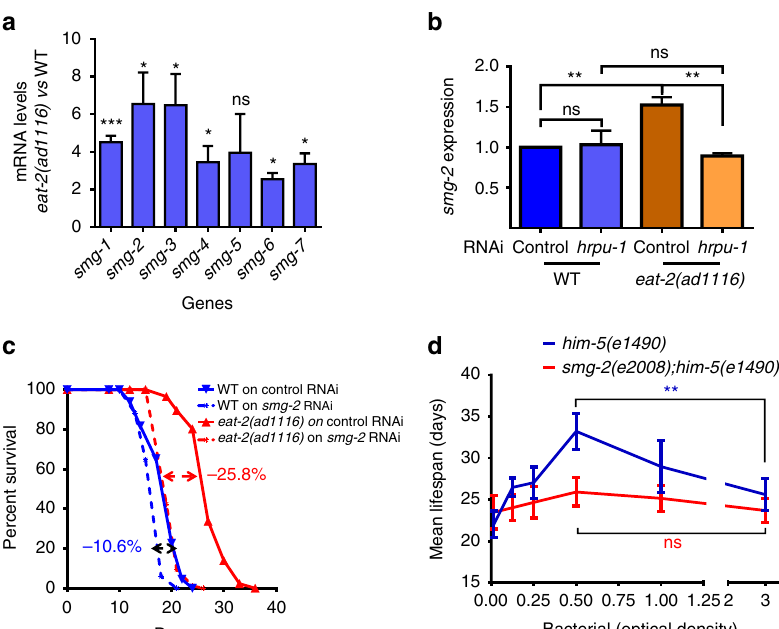
Fig. 4 MRNA surveillance pathway is upregulated and required for DR-mediated longevity. a qRT-PCR showing that genes of NMD pathway are upregulated in eat-2(ad1116) at day 1 of adulthood. Expression levels were normalized to actin and compared to WT worms. Averages of three biological replicates are shown ( Error bars = SEM). Asterisks indicate statistically signi fi cant differences to the corresponding WT samples, as calculated by unpaired two-tailed t- test (* P ≤ 0.05; ** P ≤ 0.01, *** P ≤ 0.001, ns non-signi fi cant). b The expression of smg-2 is upregulated in eat-2(ad1116) compared to WT, in a hrpu-1 -dependent manner. The samples were collected on day 3 of adulthood. Data shown are average of three biological replicates. ( Error bars = SEM). Statistical analysis was performed using unpaired two-tailed t- test. ** P ≤ 0.01, ns non-signi fi cant. c Lifespan of WT and eat-2(ad1116 ) grown on control or smg-2 RNAi. One out of the three biological replicates are shown. Percentage of suppression of lifespan is indicated for each strain. Lifespan data for each individual experiment are provided in Supplementary Table 4. d Bell-shaped curve generated by plotting average lifespans of him-5(e1490) grown in the presence of different dilutions of bacteria. The smg-2(e2008);him-5(e1490) mutant worms failed to produce similar curve. An average of three independent biological replicates is shown. Error bars are SEM. Two-way ANOVA revealed that the lifespan extension of him-5(e1490) worms across the bacterial dilution range was signi fi cantly different from that of smg-2(e2008);him-5(e1490) ( P ≤ 0.05). Bacterial culture of OD 600 = 3.0 was the starting concentration for serial dilution. Additionally, the increase in lifespan when him-5(-) was maintained at OD 600 = 0.5 was signi fi cant as compared to OD 600